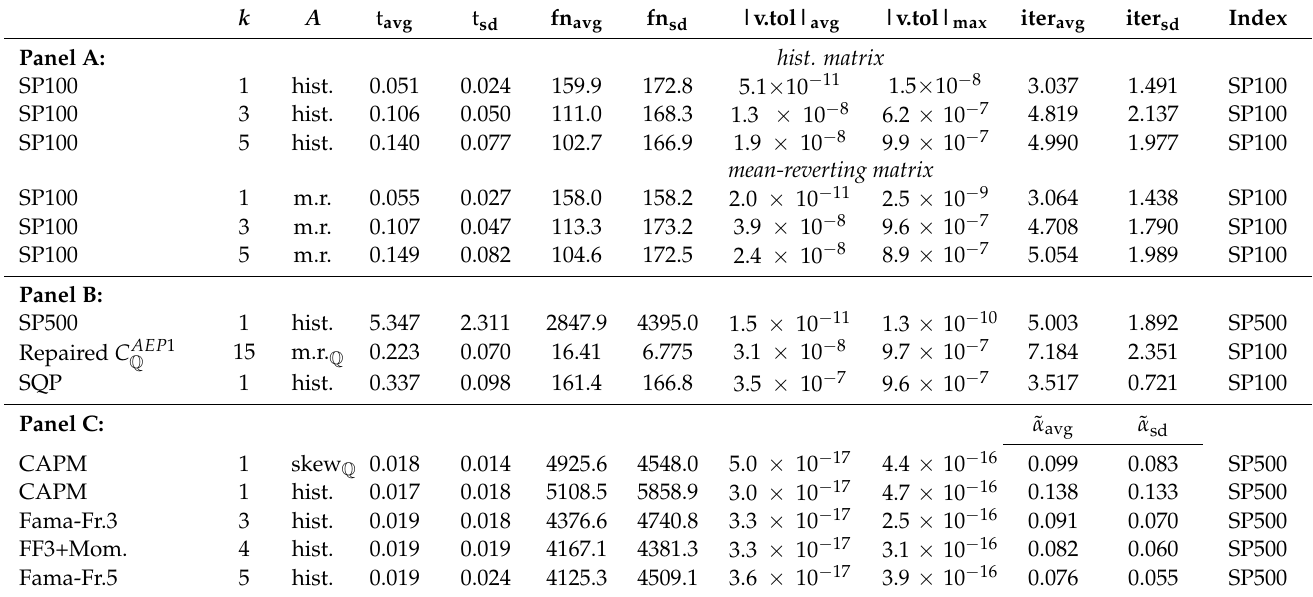
Table 2. Summary statistics of computing nearest (quantitative approach, Panels A–B) and risk-factor structured (economic approach, Panel C) implied correlation matrices on monthly option data. As for the quantitative approach, it turns out that computations were carried out in a small amount of time, converging towards the optimal solution within few iterations. The nearest factor-structured matrix can thus be used either as a stand-alone estimate, or as a tool to repair positive semi-definiteness and invertibility. Using the economic approach, implied as well as common risk factors from models, such as CAPM or Fama–French, can be used to estimate the implied correlation